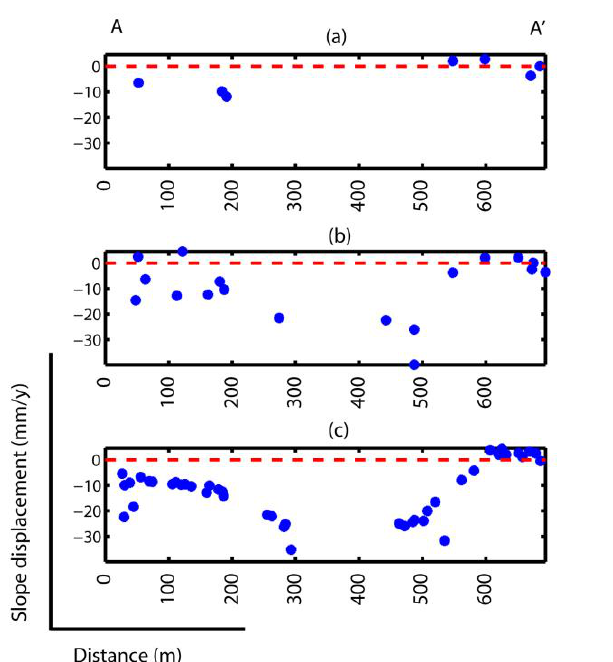
Figure 6. Mean slope displacement plotted for profile AA' in Figure 4(a). (a), (b) and (c) show the profiles resulted from PSI, SBAS and SqueeSAR methods